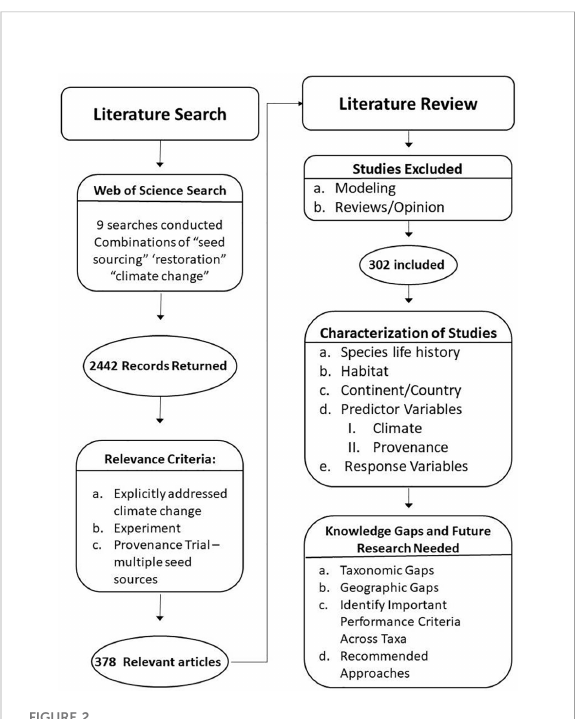
FIGURE 2 Process fl ow diagram illustrating literature search, review, and characterization of